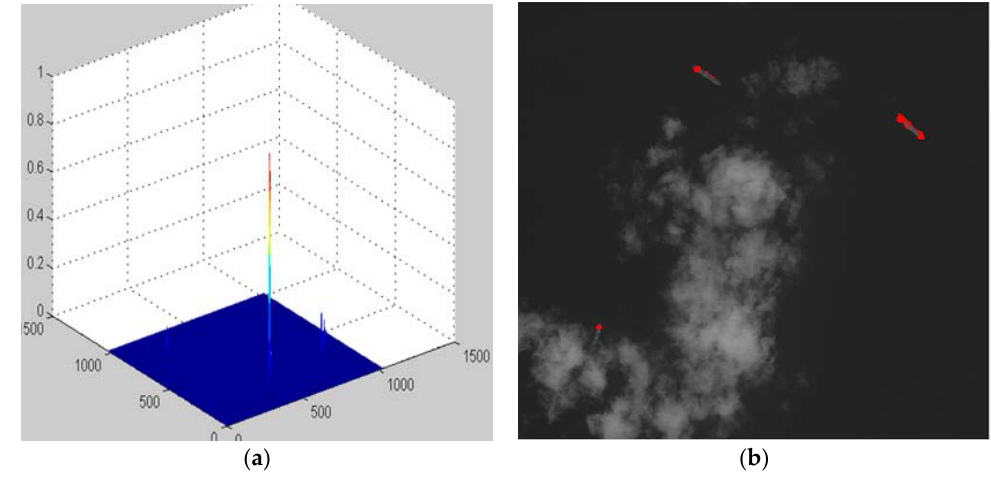
Figure 11. The localization results of cloud coverage by PSMEWT. ( a ) The three-dimensional display of PSMEWT; ( b ) the localization results of PSMEWT.